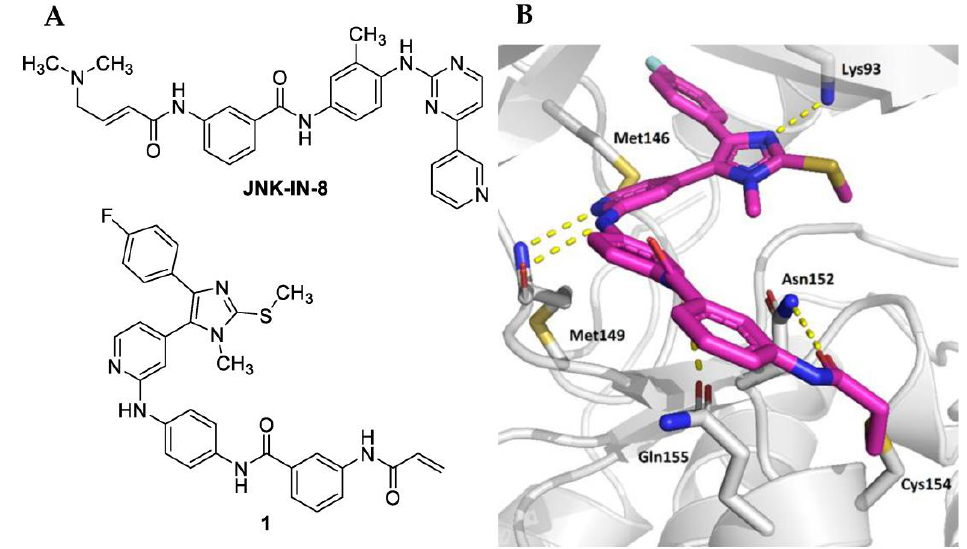
Figure 1. ( A ) Structures of covalent pan-JNK inhibitors JNK-IN-8 and 1 . ( B ) Crystal structure of compound 1 in complex with JNK3 (PDB code — 7ORF). Polar contacts are indicated by yellow dashed lines.